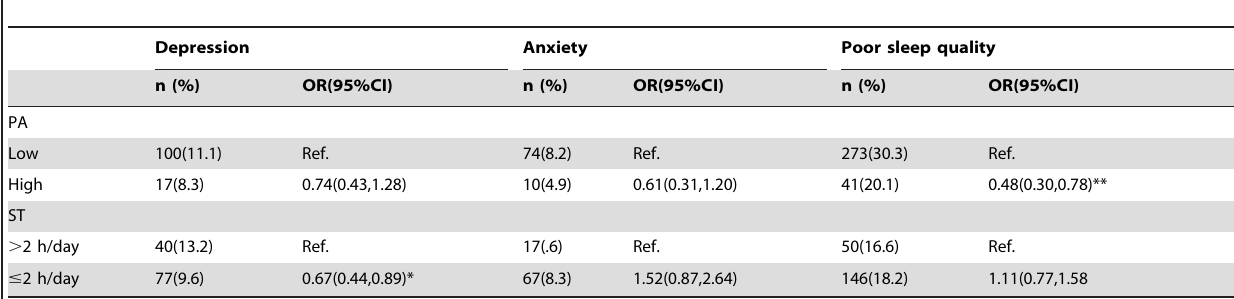
Table 2. Associations between physical activity, screen time and depression, anxiety, sleep quality among Chinese college